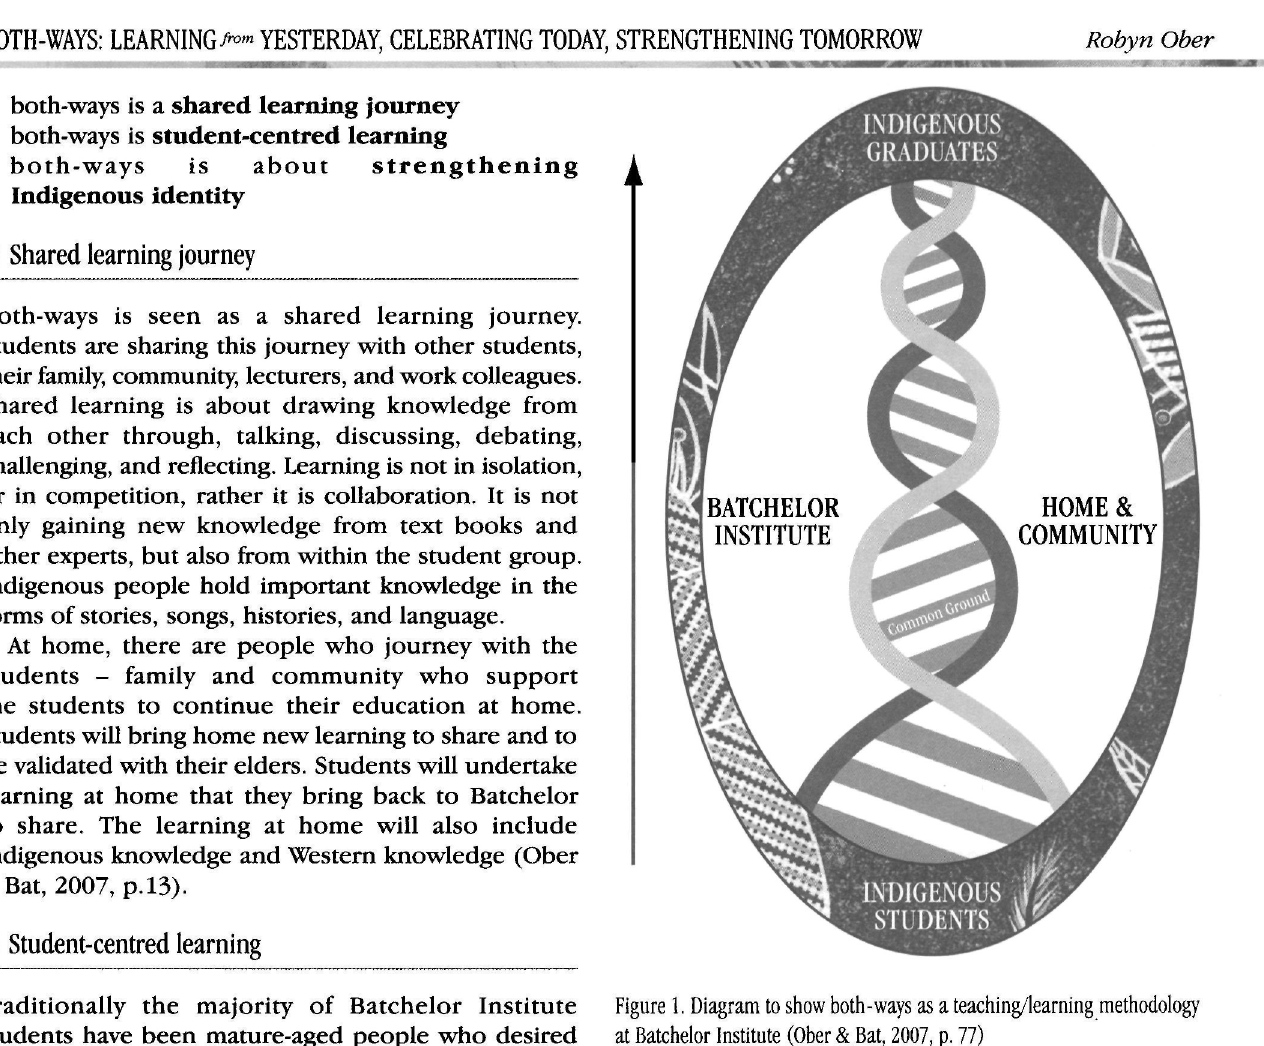
Figure 1. Diagram to show both-ways as a teaching/learning methodology at Batchelor Institute (Ober & Bat, 2007, p.